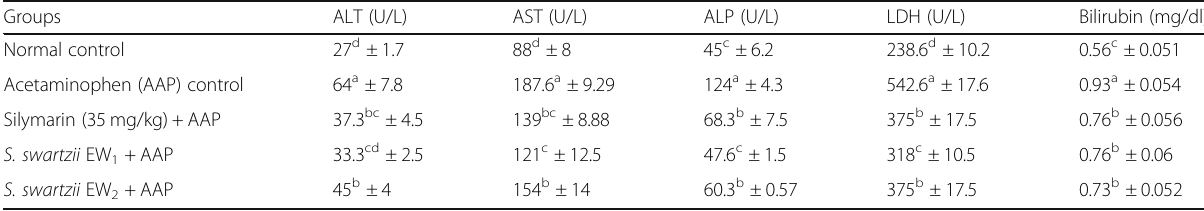
Table 1 Effect of Crude Sulphated Polysaccharides of Sargassum swartzii on Liver Enzymes and Bilirubin in Acetaminophen-Intoxicated Rats Groups